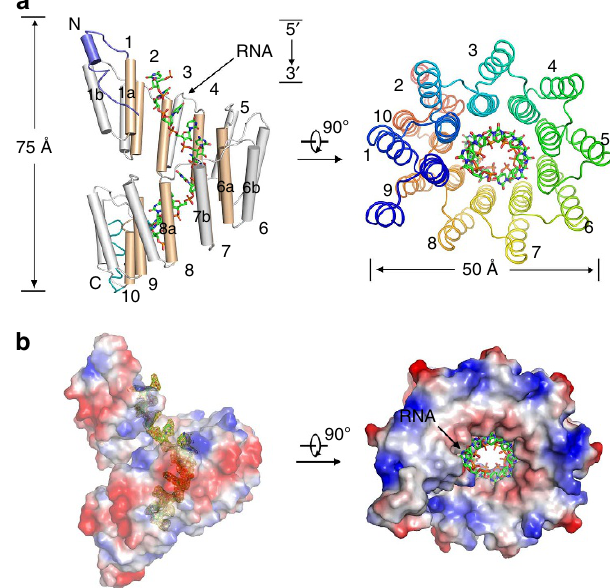
Figure 2 | Overall structure of RNA-bound dPPR-U 8 C 2 . ( a ) Overall structure of dPPR-U 8 C 2 bound to its target RNA element. dPPR-U 8 C 2 comprises 10 repeats capped by a small NTD helix (slate) and a CTD helix (cyan). The 10 dPPR repeats of dPPR-U 8 C 2 form a right-handed superhelical assembly. Wheat and grey bundles indicate helix a and helix b, respectively. ( b ) Electron density of target RNA is clearly visible in the cavity of the dPPR superhelix. The electron density, contoured at 1 s , is shown in yellow. The surface electrostatic potential was calculated with PyMOL. Two perpendicular views are presented, with the ssRNA molecule depicted as sticks. All structure figures were prepared using